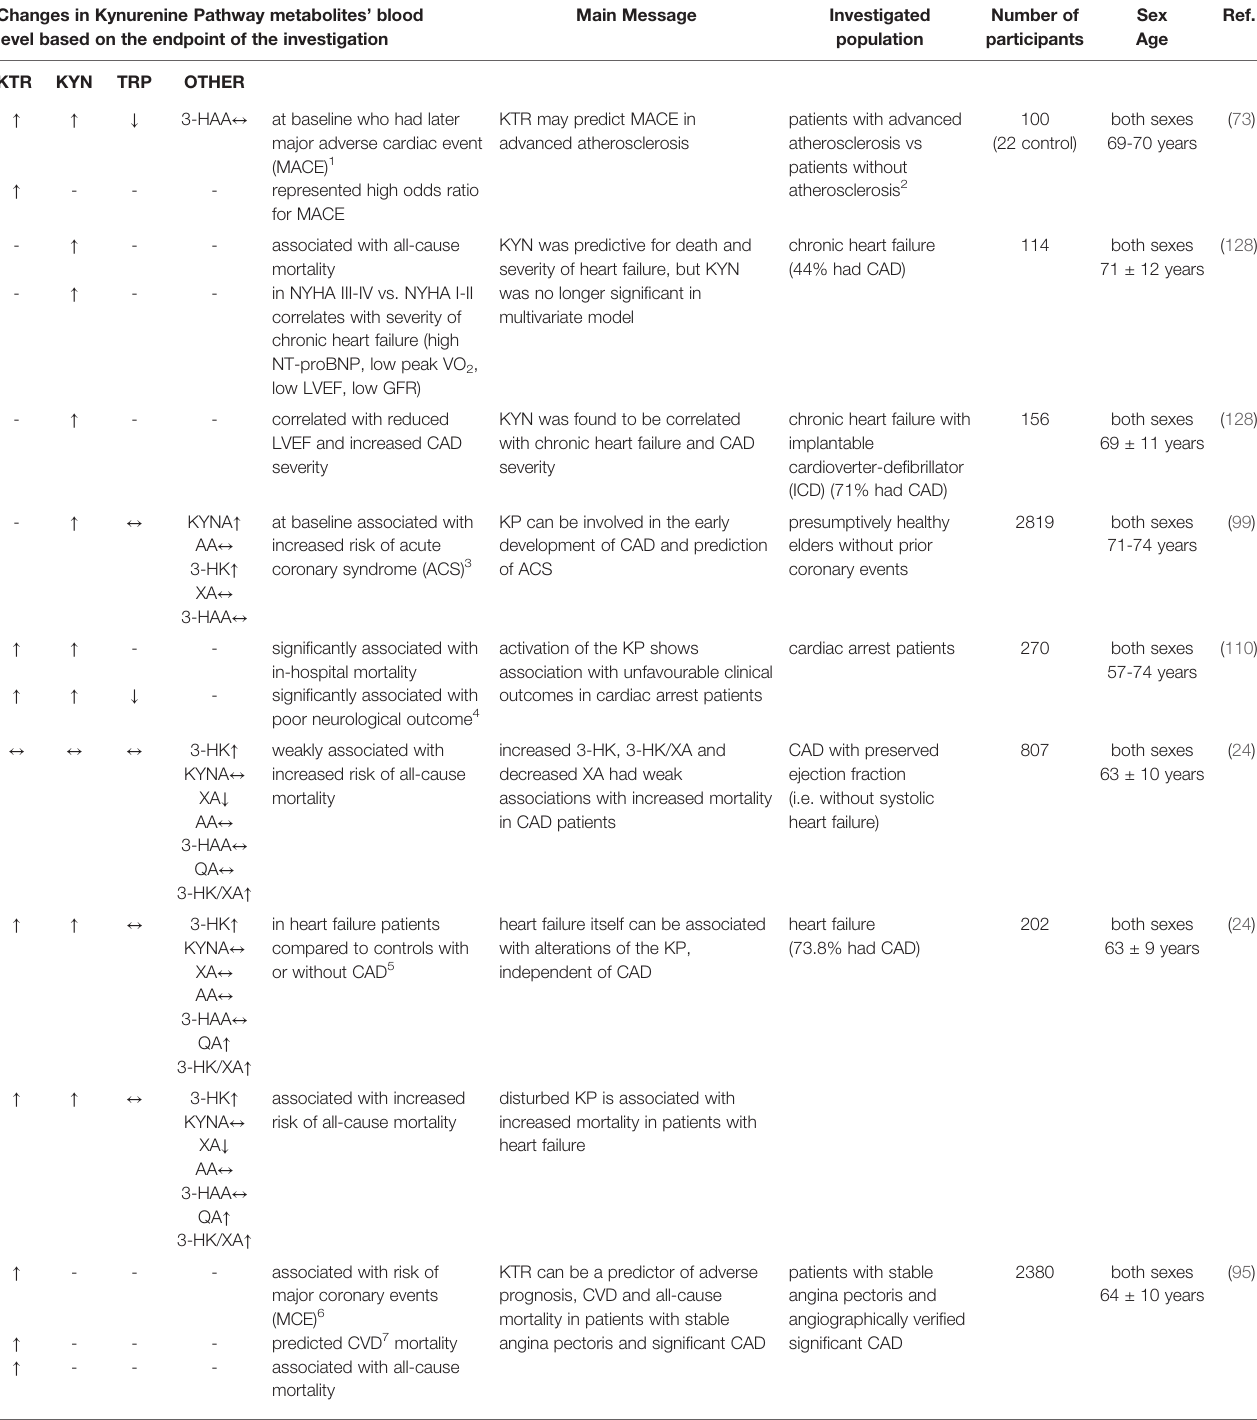
TABLE 4 | Circulating kynurenine pathway (KP) metabolites related to coronary artery diseases (CAD): potential markers. Changes in Kynurenine Pathway metabolites ’ blood level based on the endpoint of the